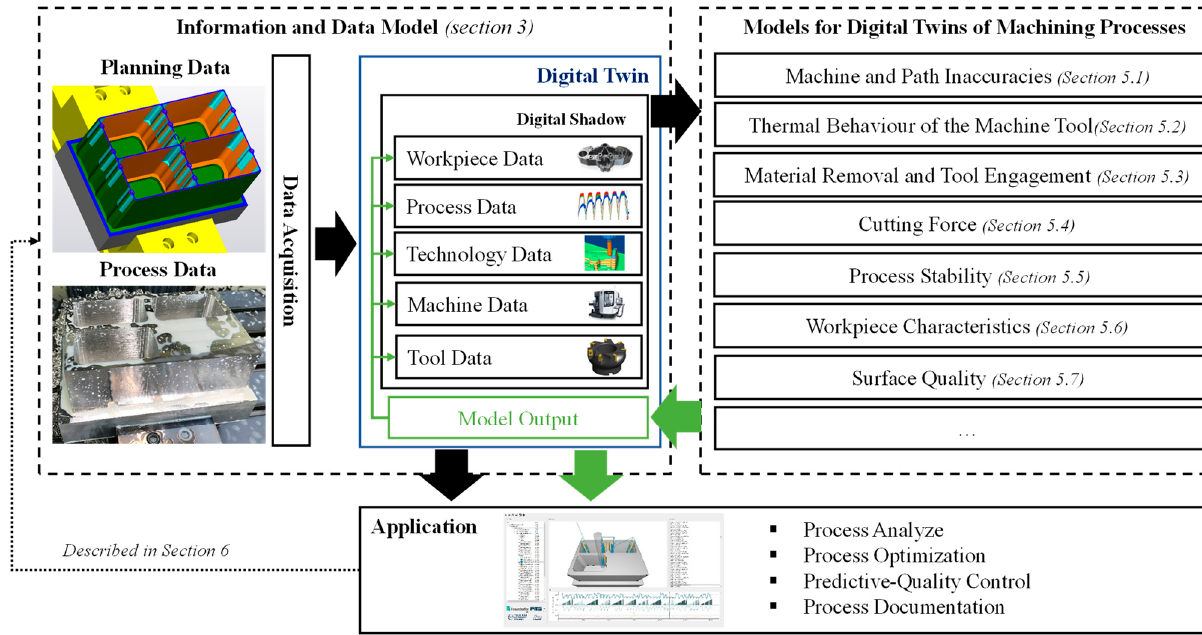
Figure 1. Basic structure of a digital twin for machining processes.